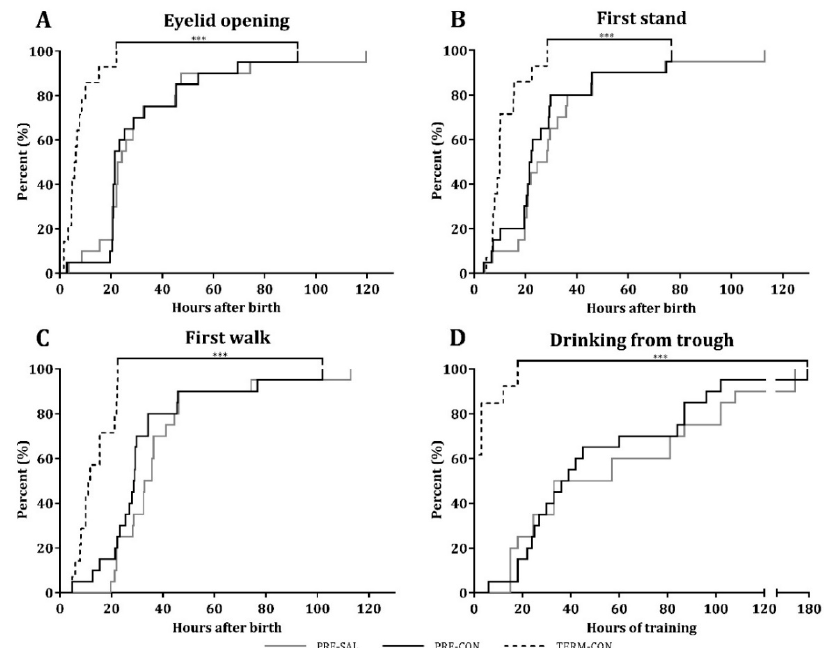
Figure 2. Basic motor skill acquisition. Hours before a given percentage of piglets was observed to open their eyes ( A ), stand for the first time ( B ), walk ( C ), or first voluntarily completion of a full milk bolus from an open trough ( D ). PRE-SAL (grey line), PRE-CON (black line) and TERM-CON (dotted line). *** PRE-CON and TERM-CON ( p < 0.001).